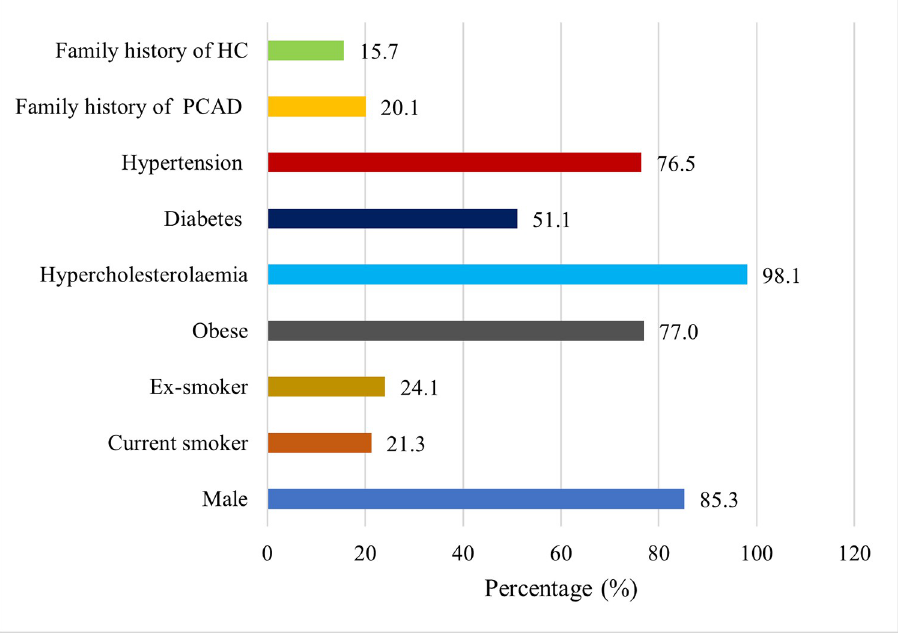
Fig 2. Conventional risk factors among individuals with PCAD (n = 319). Data presented as percentage (%); HC: Hypercholesterolaemia, PCAD: Premature coronary artery